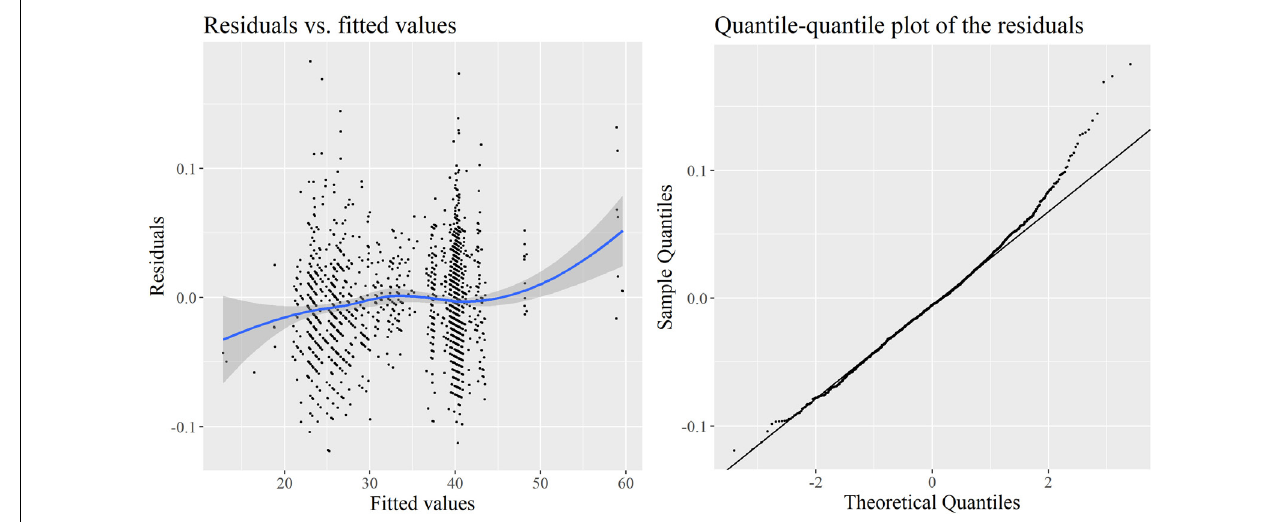
FIGURE 3 | Diagnostics for the inverse-Gaussian GLMM: deviance residuals vs. fitted values (left) and quantile–quantile plot of these residuals (right)